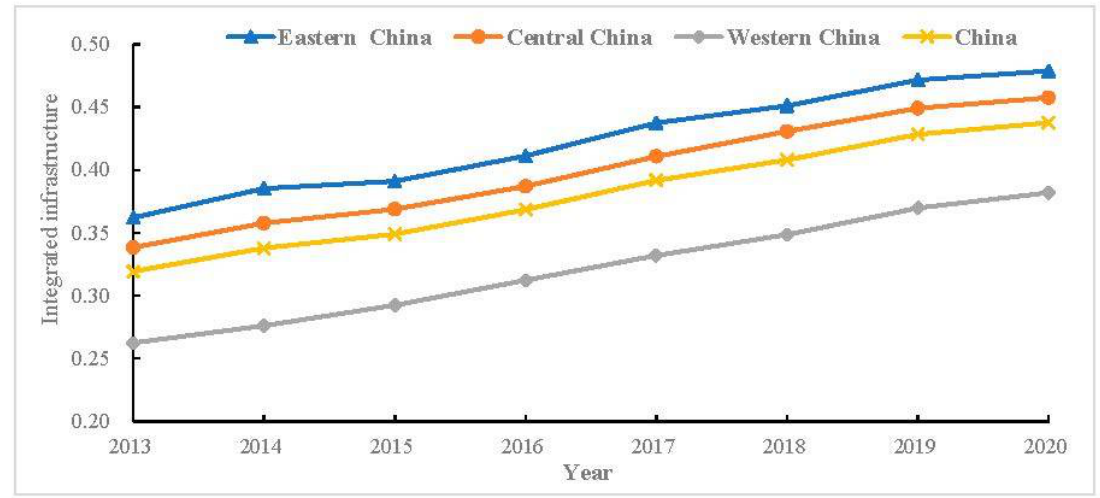
Figure 2. Integrated infrastructure in China and three different regions from 2013 to 2020.